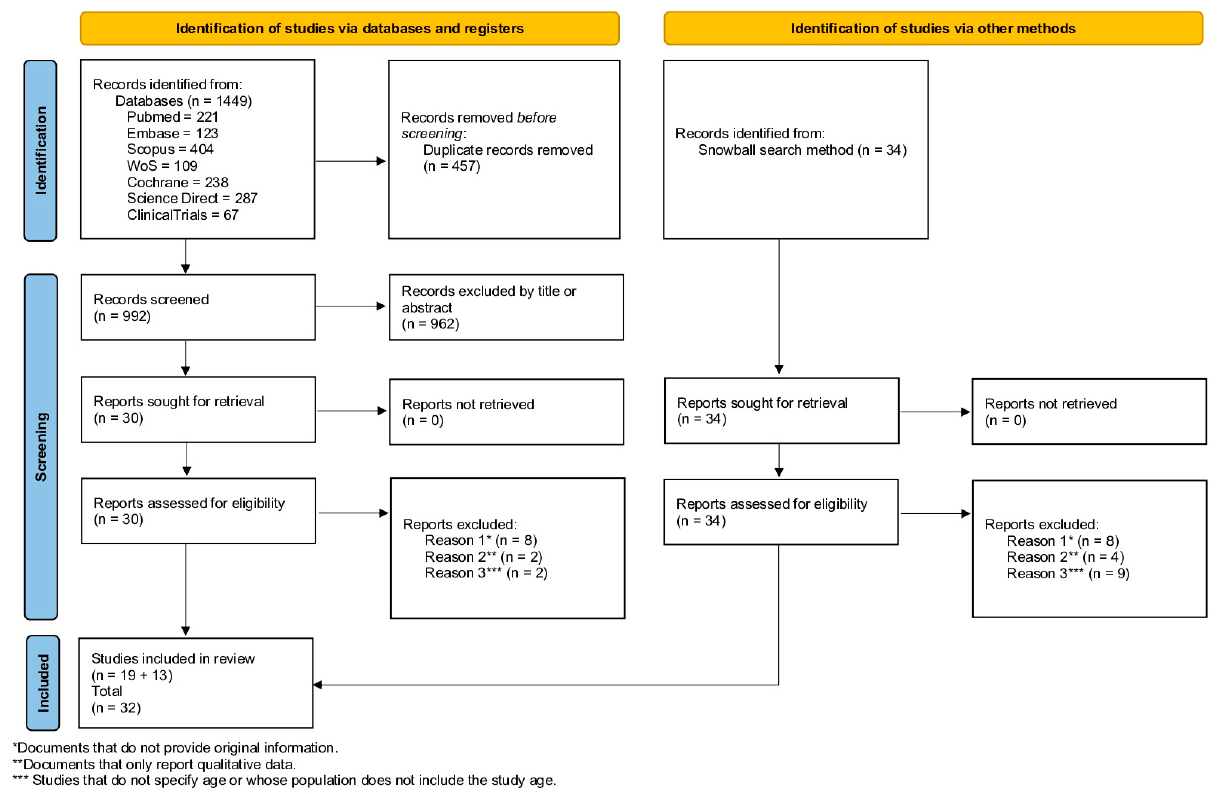
Figure 1. PRISMA diagram of study flow.